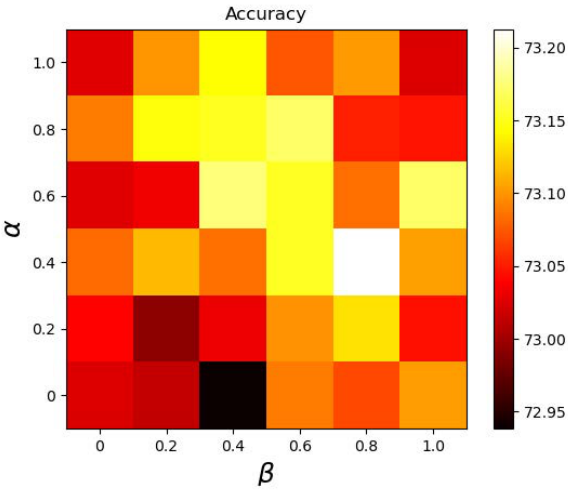
Figure 5. homogeneous adjacency matrix parameter adjustment.